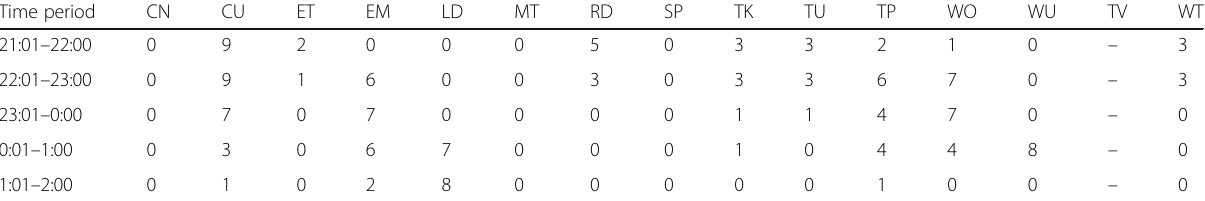
Table 18 Time – activity table for Saturday for eButton wearer 2